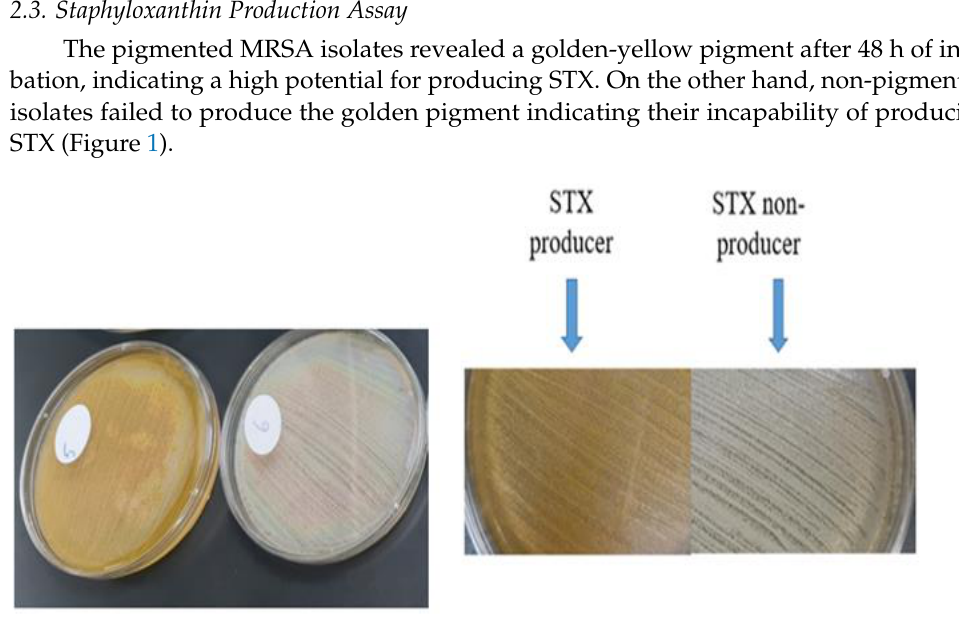
Figure 1. STX production in pigmented isolates versus non-pigmented isolates.